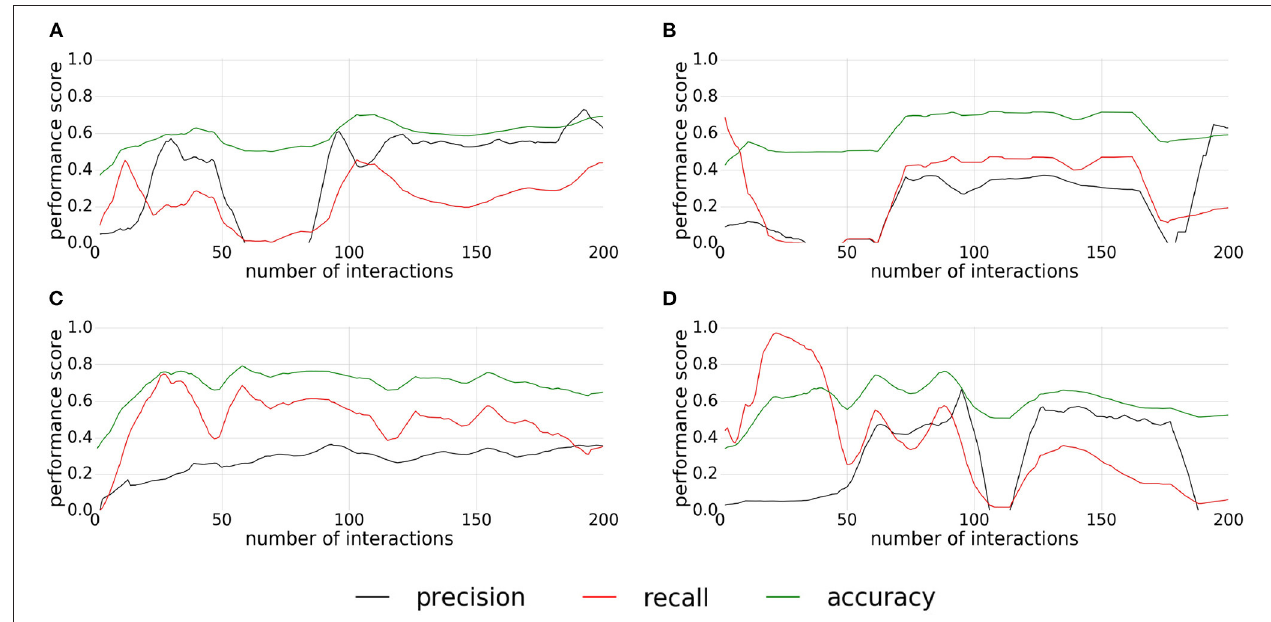
FIGURE 11 | (A–D) Plots of precision, recall, and accuracy for pressable buttons. Each plot correspond to one replication of the experiment.